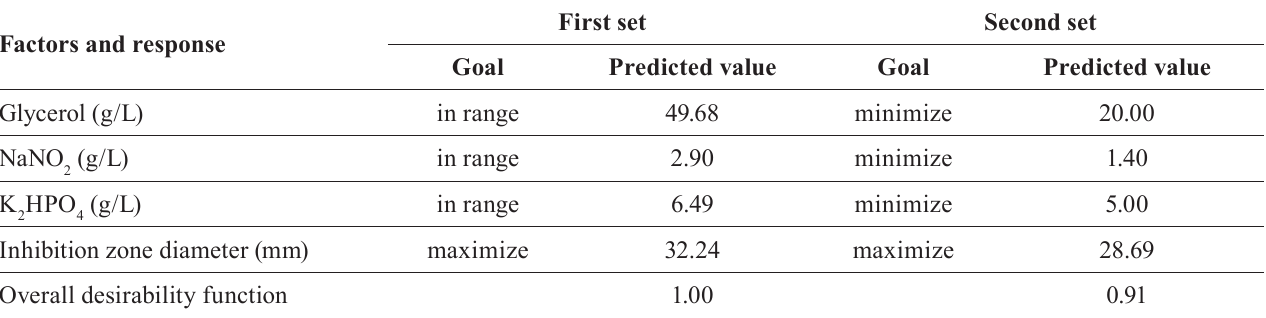
TABLE III - Optimal values of varied factors and predicted values of selected response